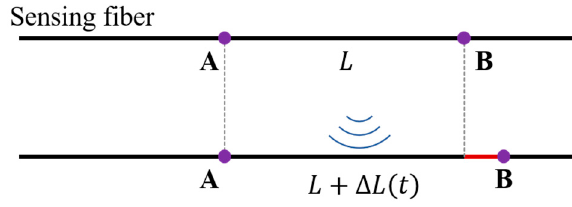
Figure 1. The sensing principle of the fiberoptic DAS.